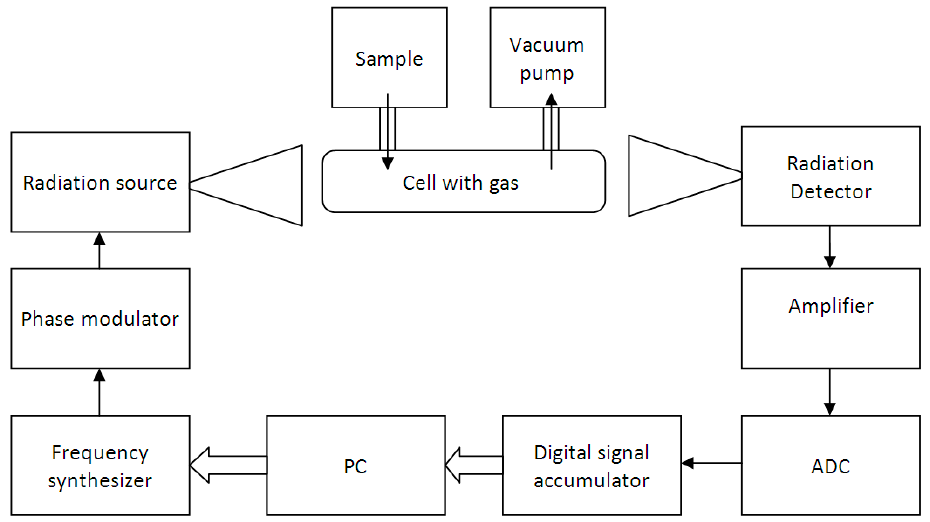
Figure 1. Block diagram of a spectrometer with phase switching of the radiation source signal. In the first case the sensitivity of the spectrometer with phase switching of the radiation acting on the gas amounts to 5 × 10 − 10 cm − 1 and in the second case is 3 × 10 − 9 cm − 1 . Another approach is fast frequency passage (sweep) through the absorption line [14]. Fast sweep makes it possible to detect all absorption lines in the entire frequency